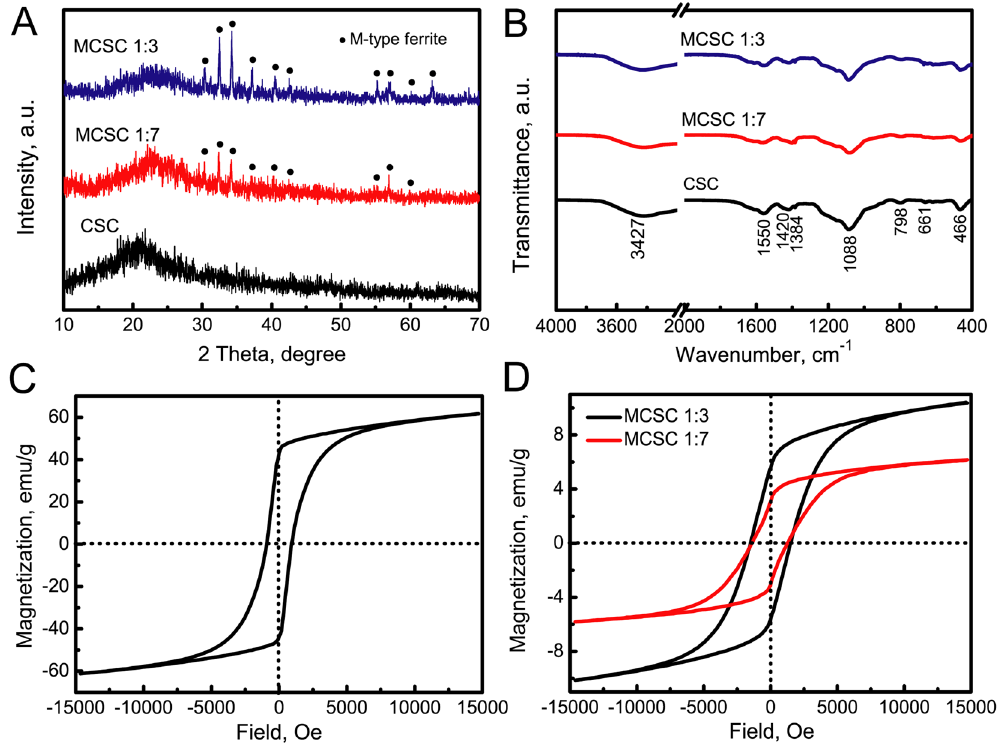
Figure 4. The phases of scaffolds were characterized by XRD and FTIR. ( A ) XRD patterns and ( B ) FTIR spectra of CSC, MCSC 1:7, MCSC 1:3 scaffolds; magnetic hysteresis loops of ( C ) pure magnetic particles, ( D ) MCSC 1:3 and MCSC 1:7 scaffolds. XRD, X-ray power diffraction; FTIR, fourier transform